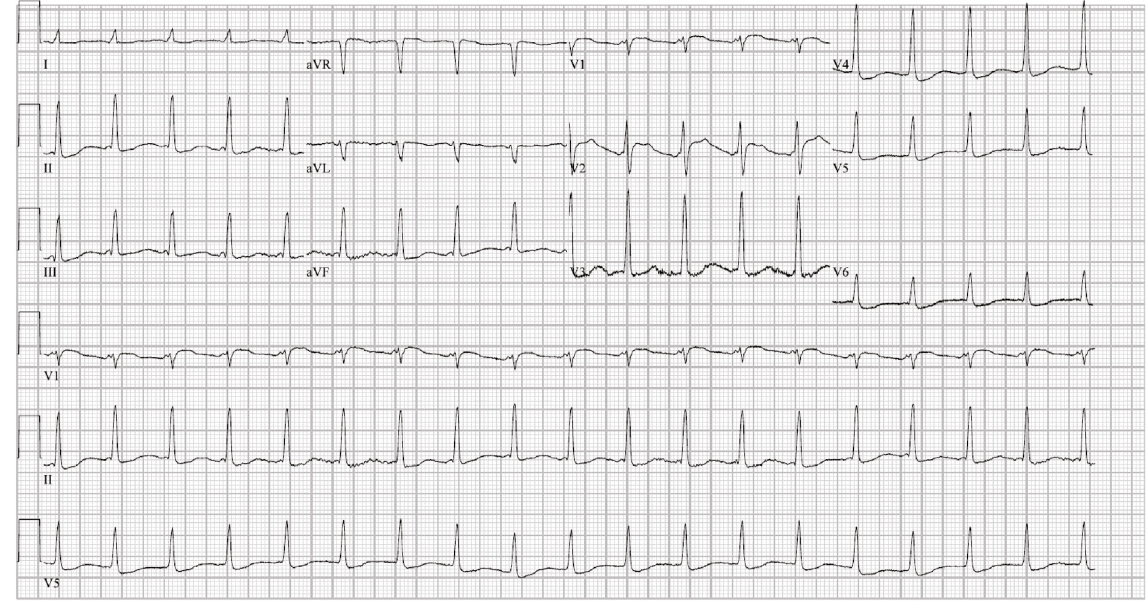
Figure 3: Electrocardiogram obtained upon arrival to the cardiovascular intensive care unit demonstrating supraventricular tachycardia (ectopic atrial versus junctional tachycardia), early R-wave transition in the precordial leads, di ff use ST and T wave changes, and QT prolongation most likely secondary to myocardial injury/ischemia and metabolic abnormalities due to cardiac